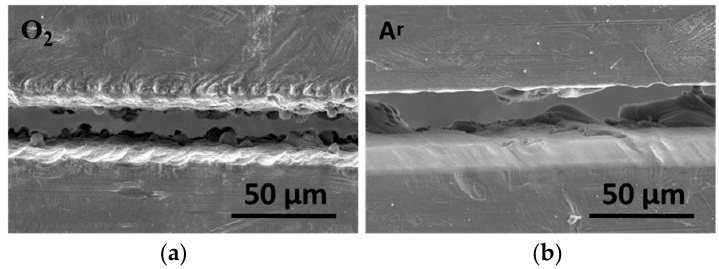
Figure 6. Kerf geometry and dross formation of the cuts before the acid pickling process: ( a ) oxygen cut; and ( b ) argon cut. Appl. Sci. 2017 , 7 , 608 Figure 7. Kerf cross-sections of the cuts with the acid pickling process: ( a ) oxygen cut; and ( b ) argon cut. Unneat kerfs influence the stents’ dimension accuracy, as well as the surface quality. Dross a person’s health after being implanted into a vein.